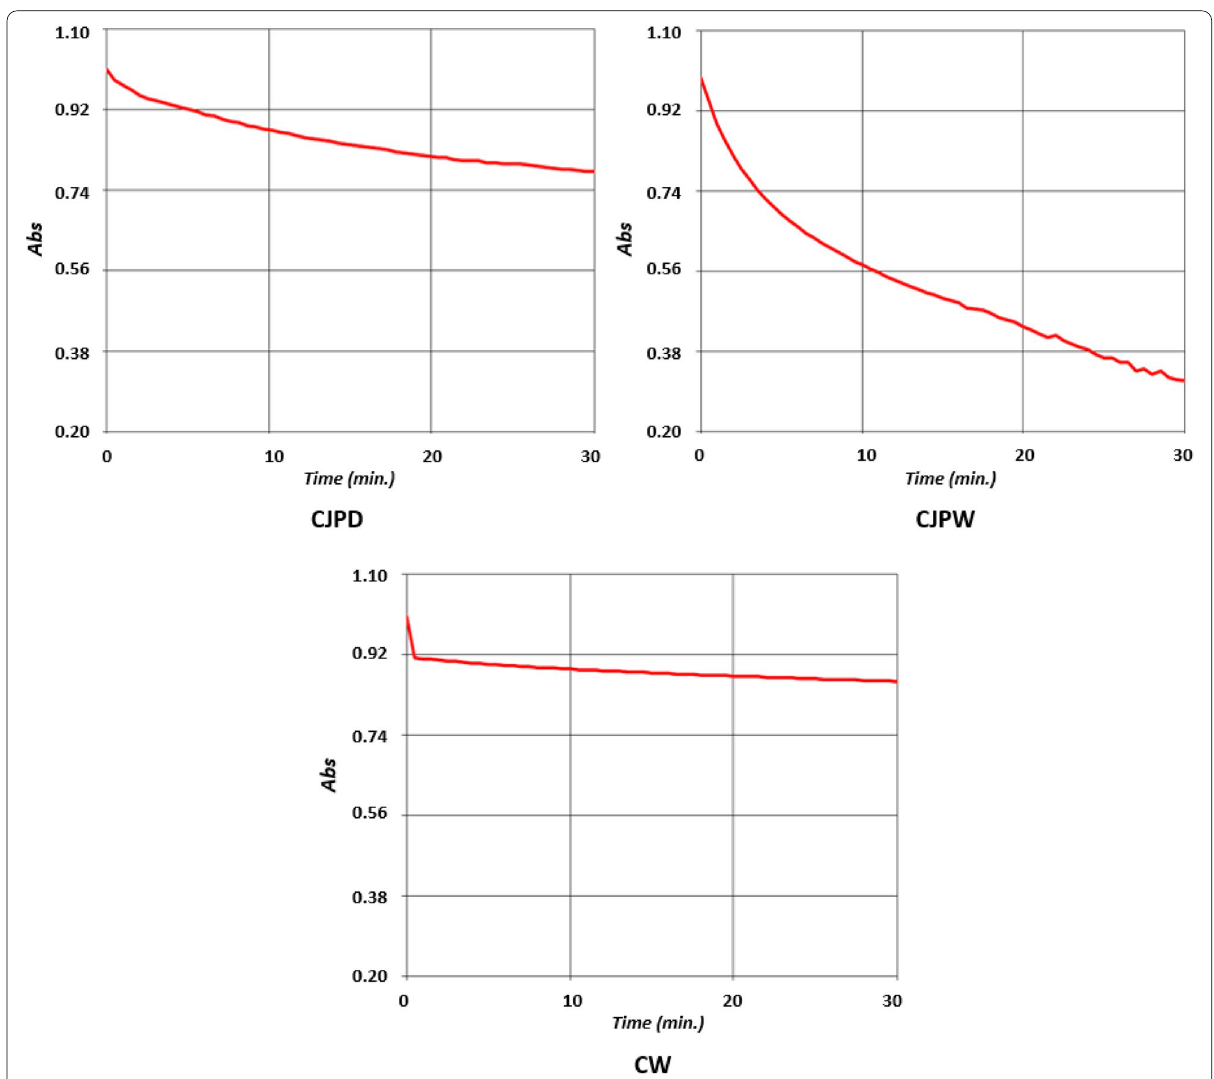
Fig. 4 Results of DPPH inhibition kinetics assay showing a prominent and faster rate of DPPH inhibition by fermented petal wine (CJPW)